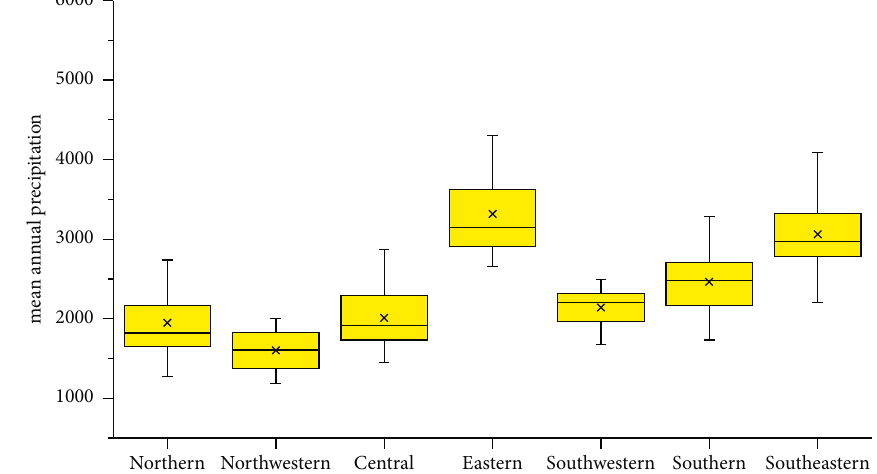
Figure 7: Regional difference in precipitation in